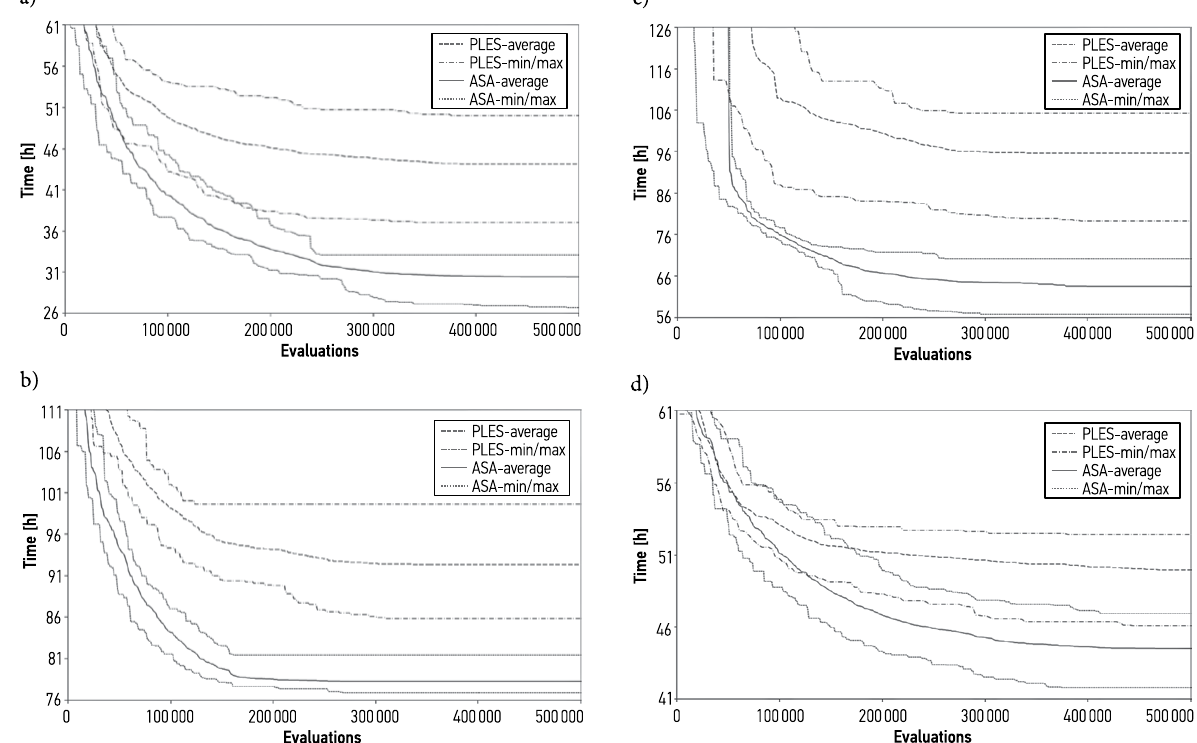
Fig. 5 . Performance of the PLES and the ASA for group transportation in: a – Task 1; b – Task 2; c – Task 3; d – Task 4